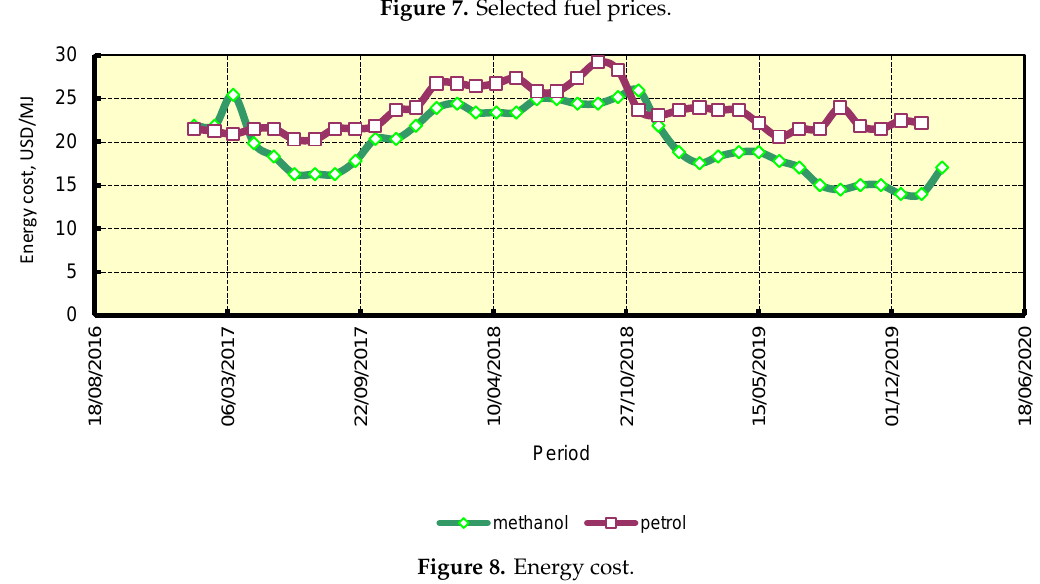
Figure 8. Energy Figure 8. Energy cost. Figure 8. Energy cost.